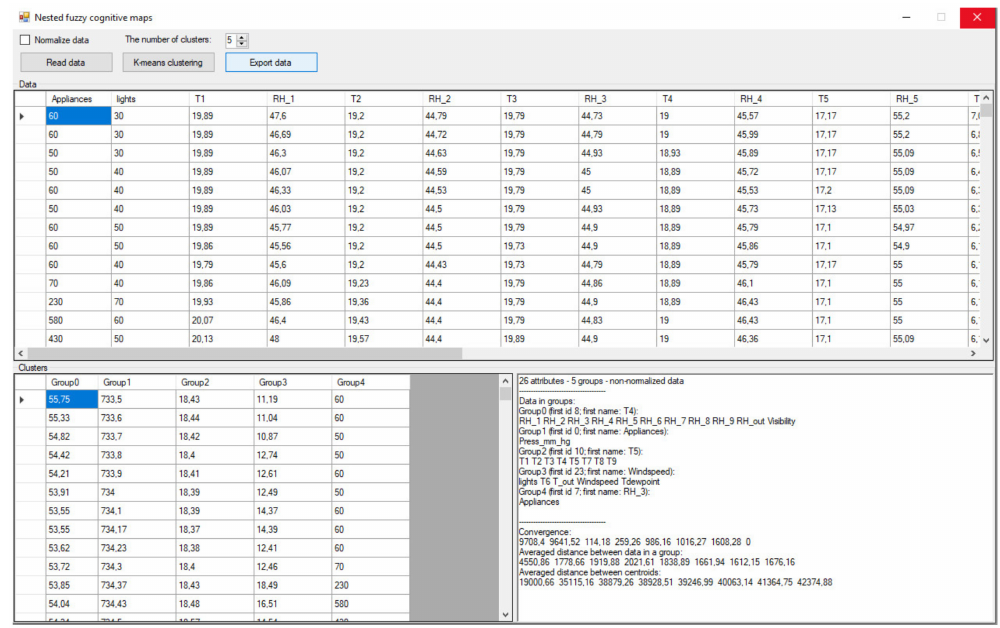
Figure 2. Screenshot of the implemented ISEMK (Intelligent Expert System based on Cognitive Maps) module for data